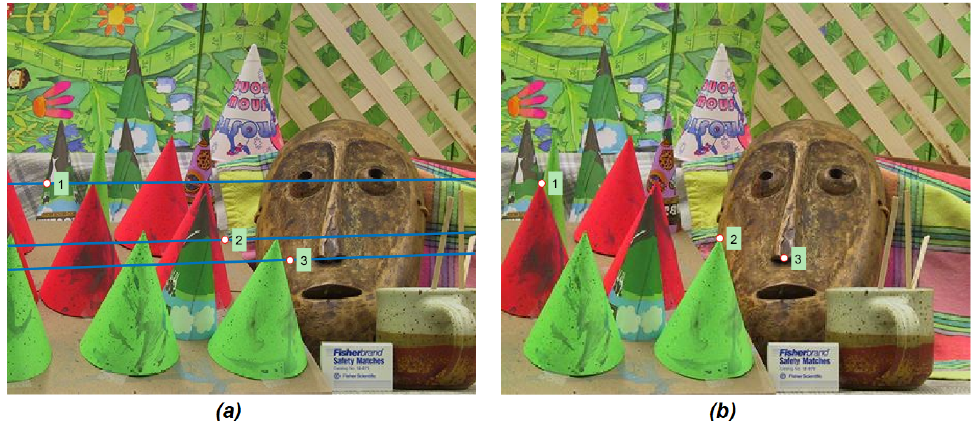
Figure 3. Considering any point in the right image ( b ) I R (1, 2, and 3), the method in [20] searches the corresponding points in the left image I L by computing their epipolar lines ( a ).